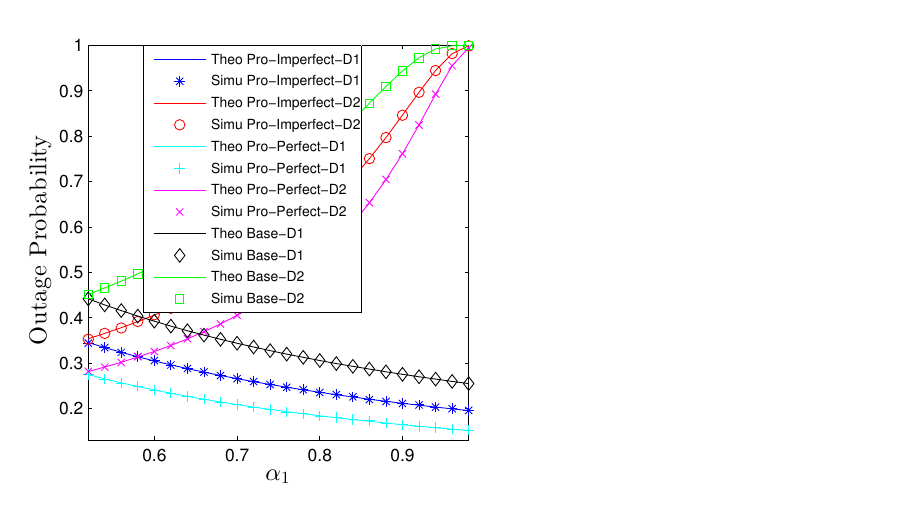
Figure 8. Outage probability vs. α 1 under all schemes. Solid lines are plotted by employing (15)–(17) while markers are Monte Carlo simulation.